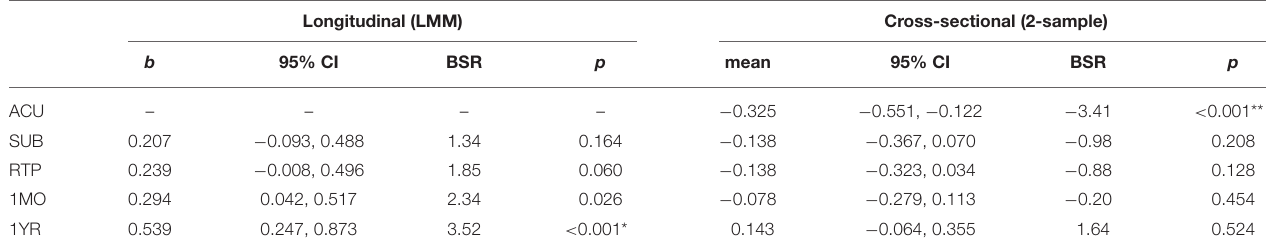
TABLE 2 | Longitudinal effects of concussion on blood-oxygenation-level-dependent (BOLD) response, averaged over significant task time points (35–55s). Longitudinal (LMM) Cross-sectional (2-sample) 95%